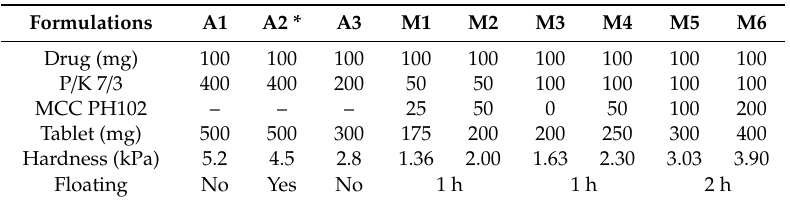
Table 5. Composition of formulations A1–A3 and M1–M6.